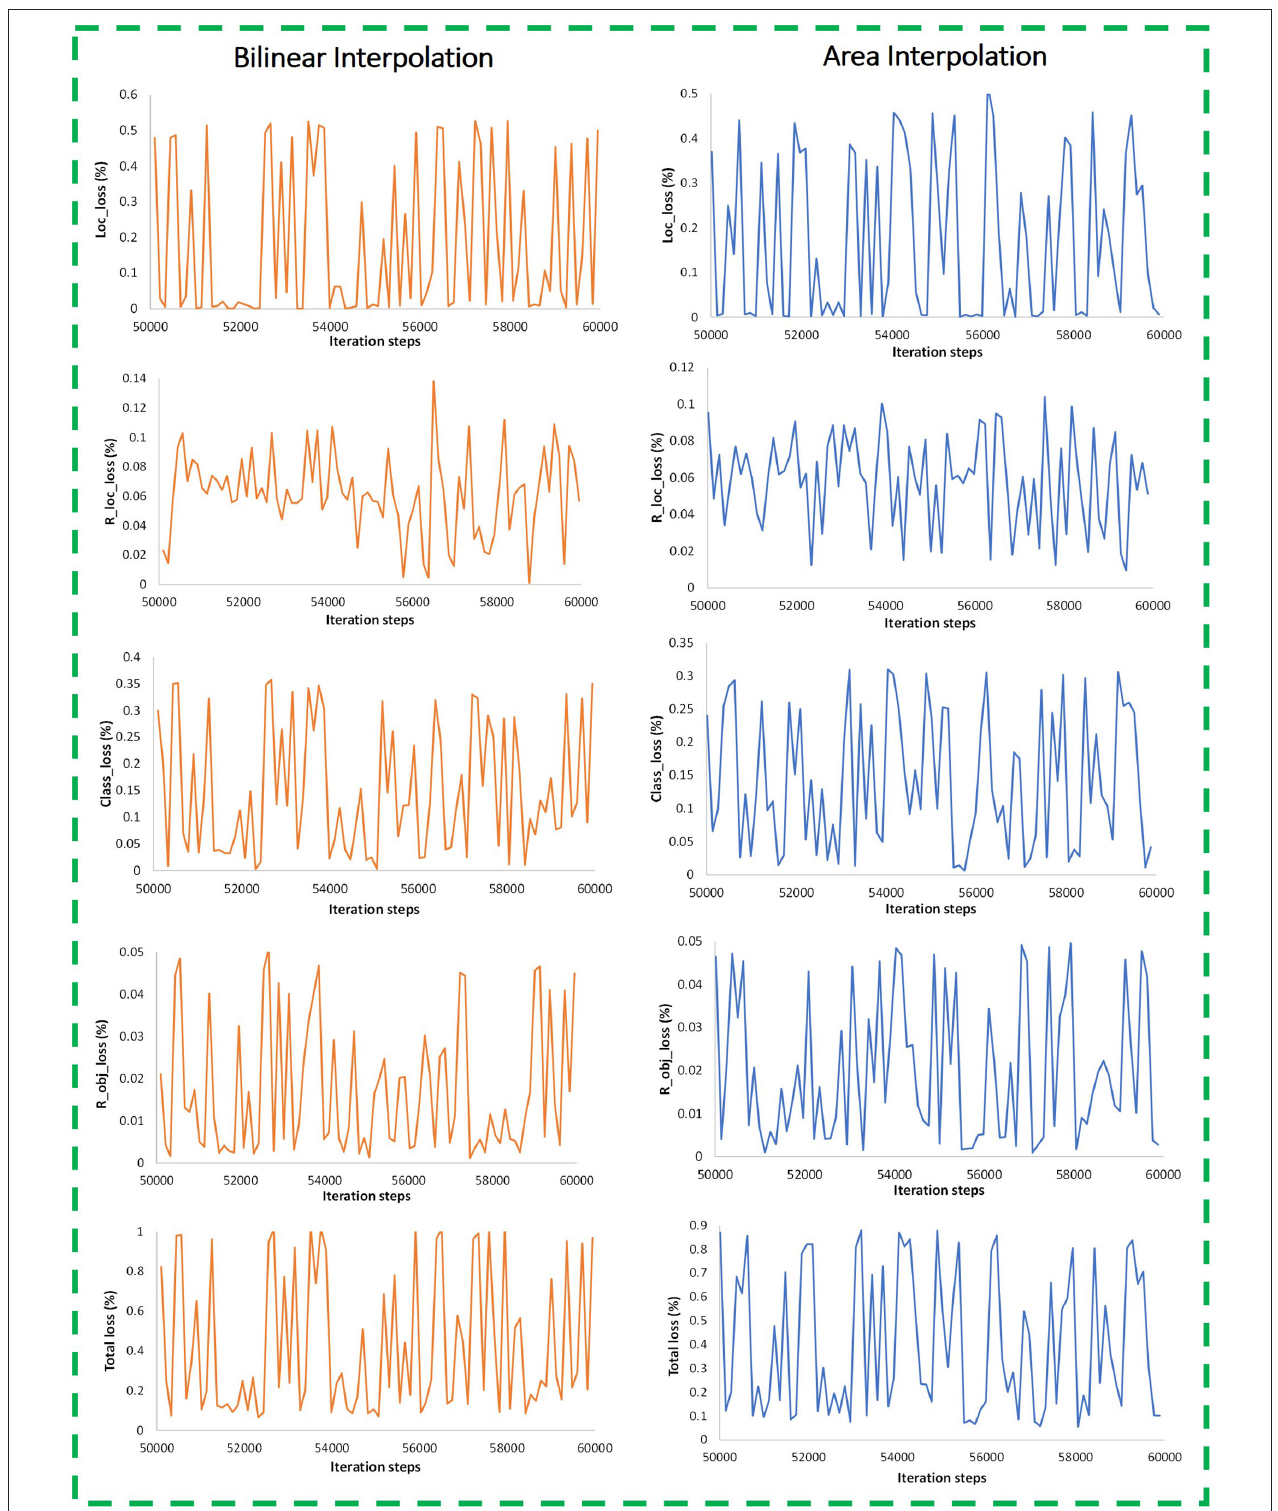
FIGURE 10 | Training plots for bilinear and area interpolation methods with aspect ratio image resizer (iteration steps from 50K and onwards are shown, when the model got training convergence).